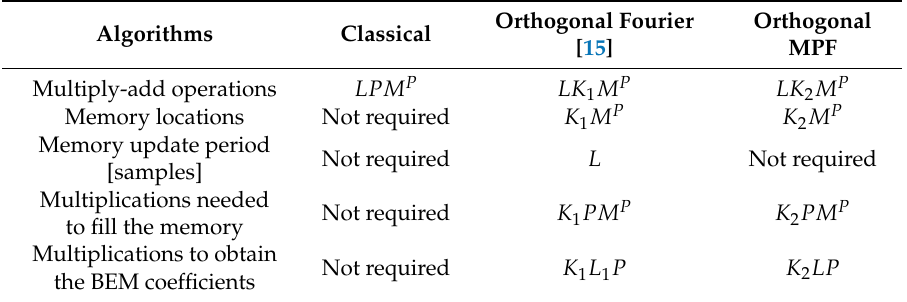
Table 2. Complexity and memory-requirement comparison to obtain { ˜ y l | b l } L − 1 the prolate functions (MPFs), basis expansion modeling